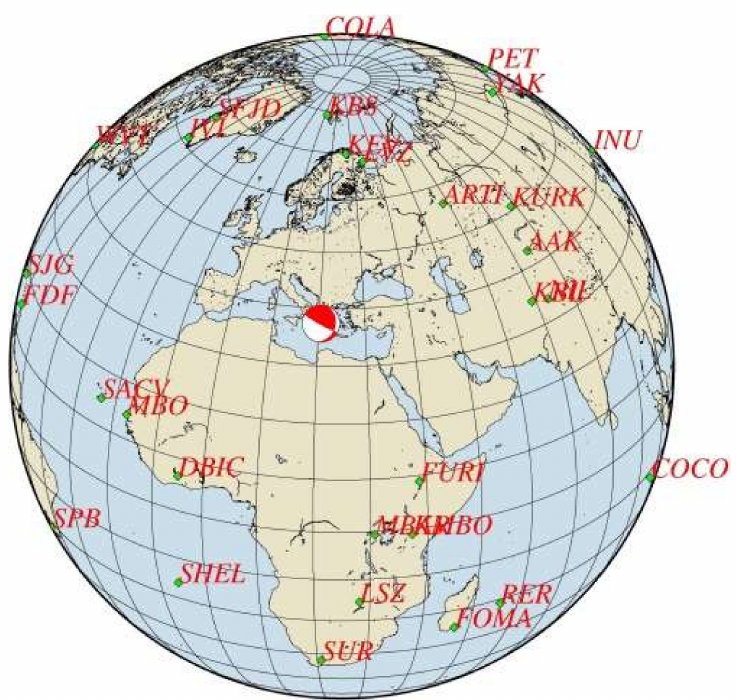
Figure 5. P-wave records of the 25 October 2018 mainshock were downloaded from 30 teleseismic